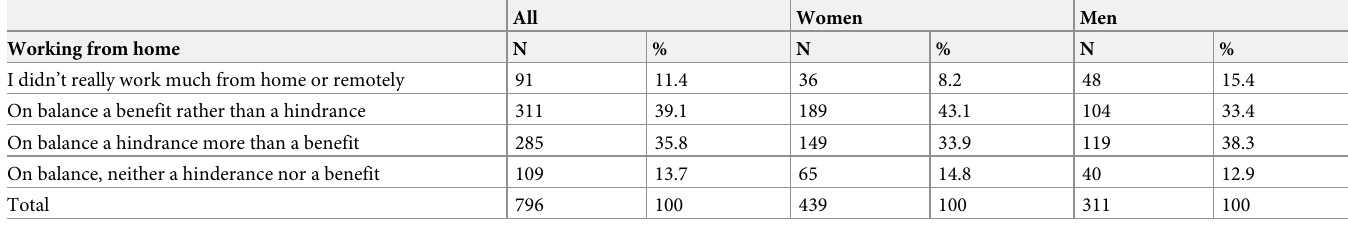
Table 3. Was working from home and/or working remotely a benefit or a hindrance?